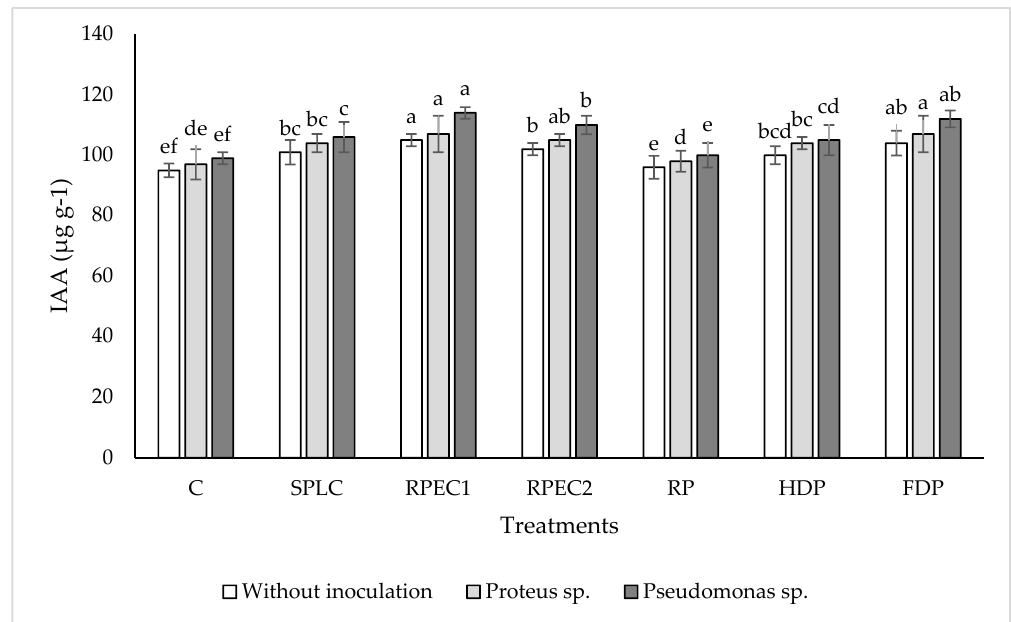
Figure 1. Effects of PGPR, P-enriched compost and inorganic fertilizers on leaf chlorophyll concentration (µg g - 1 ). C-Control; SPLC-Poultry litter only; RPEC1-Rock phosphate + poultry litter solubilized with Pseudomonas sp. during the composting process; RPEC 2 -Rock phosphate + poultry litter solubilized with Proteus sp. during composting process), RP-Rock phosphate + poultry litter; HDP- Half dose inorganic P from Single Super Phosphate-SSP 18% P 2 O 5 ; FDP- Chemical fertilizer (Single Super Phosphate). All the treatments sharing common letter are similar otherwise they differ significantly at p ≤ 0.05.